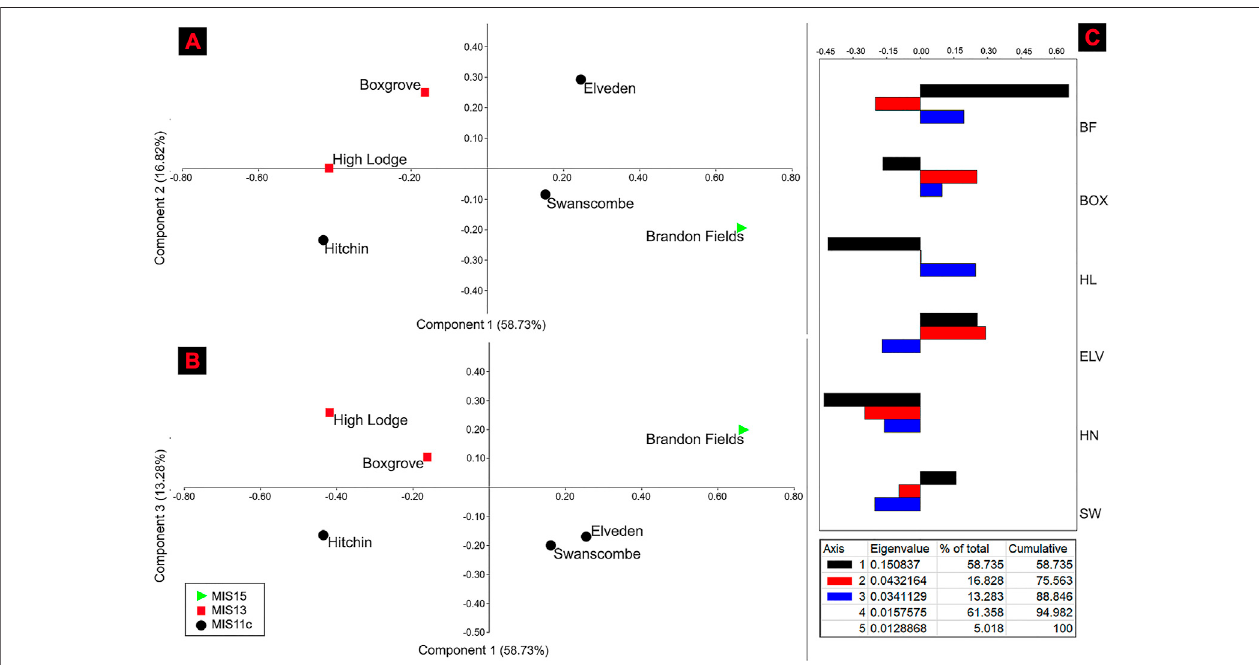
FIGURE 4 | Correspondence Analysis (CA) resulting from combining all the technological features by sites (SOM Tables 1 – 4 ). (A) Component 1 and 2; (B) Components 1 and 3; (C) Components loadings per site. Abbreviations: BF, Brandon Fields; BOX, Boxgrove; HL, High Lodge; ELV, Elveden; HN; Hitchin, SW,